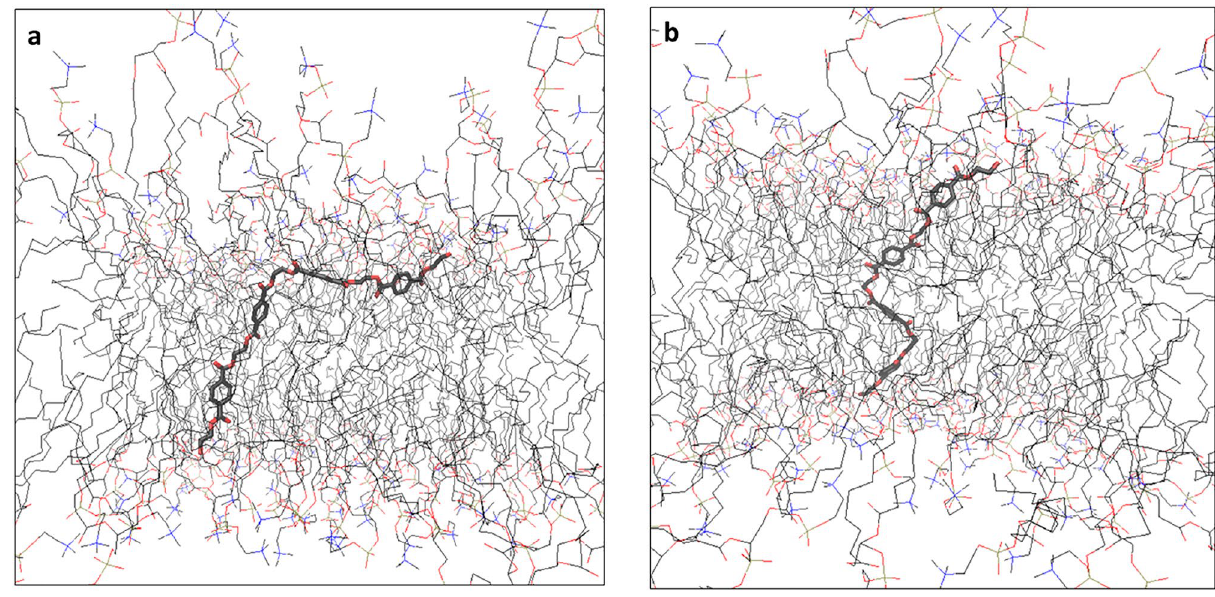
Figure 3. PET-tetramer shapes. ( a ): L-shaped PET-tetramer in POPC bilayer. ( b ): Z-shaped PET-tetramer in POPC-bilayer. Taken as snapshots from the simulations.